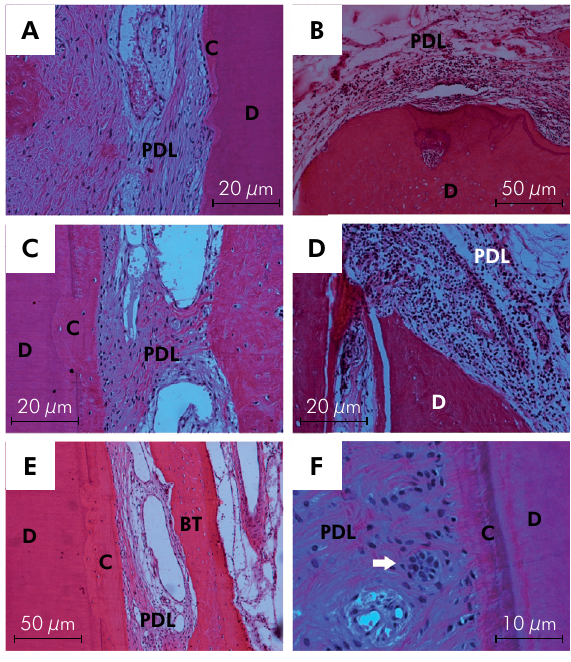
Figure 2. A - Root resorption repaired by newly formed cementum (arrow). B - Presence of acute inflammatory infiltrate in the periodontal ligament near the ramification (arrow). C - Root resorption repaired by newly formed cementum. D - Presence of acute inflammatory infiltrate near a ramification of the main canal (arrow). E - Root resorption repaired by newly formed cementum. F- Presence of epithelial cell rests of Malassez near the root surface (arrow).